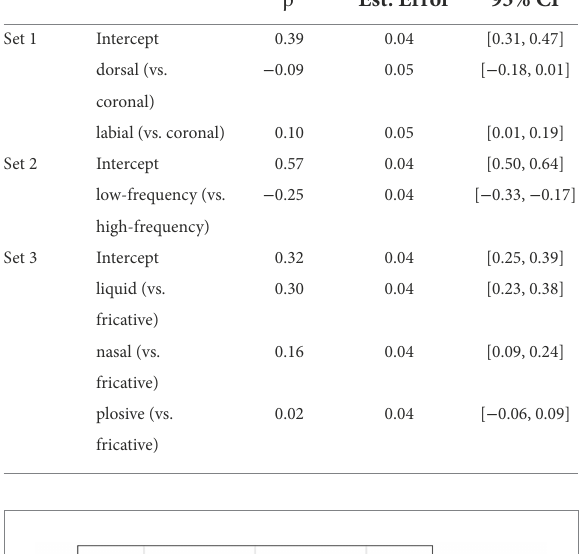
FIGURE 2 Box plots for Set 2.